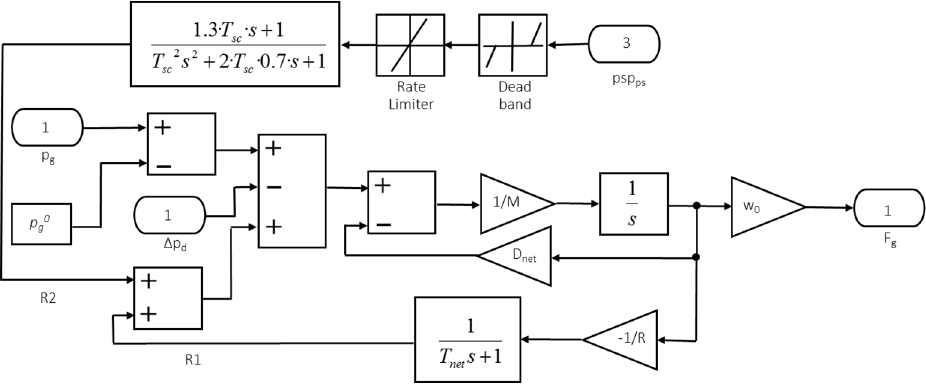
Figure 5. “DFIG electrical model” block. ( T fp (s) is the converter time constant and n syn (p.u.) is the synchronous speed of the group). Doubly fed induction generators: DFIG. 3.8. Power System A single node inertial model has been used in this paper to represent the isolated power system. This assumption is accepted for the time scale of the dynamics analyzed in this work [25,26]. The changes in the system frequency are calculated from the unbalance between total generation and demand in Equation (12), in the “power system” block: g